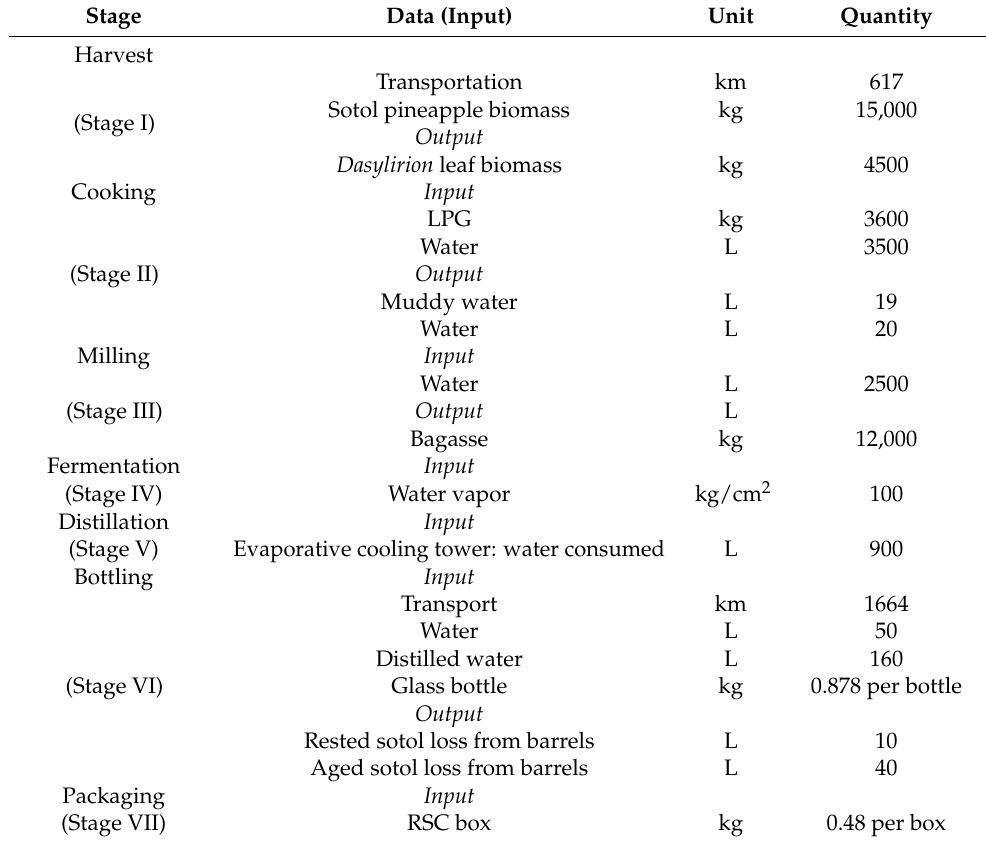
Table 1. Main empirical data for